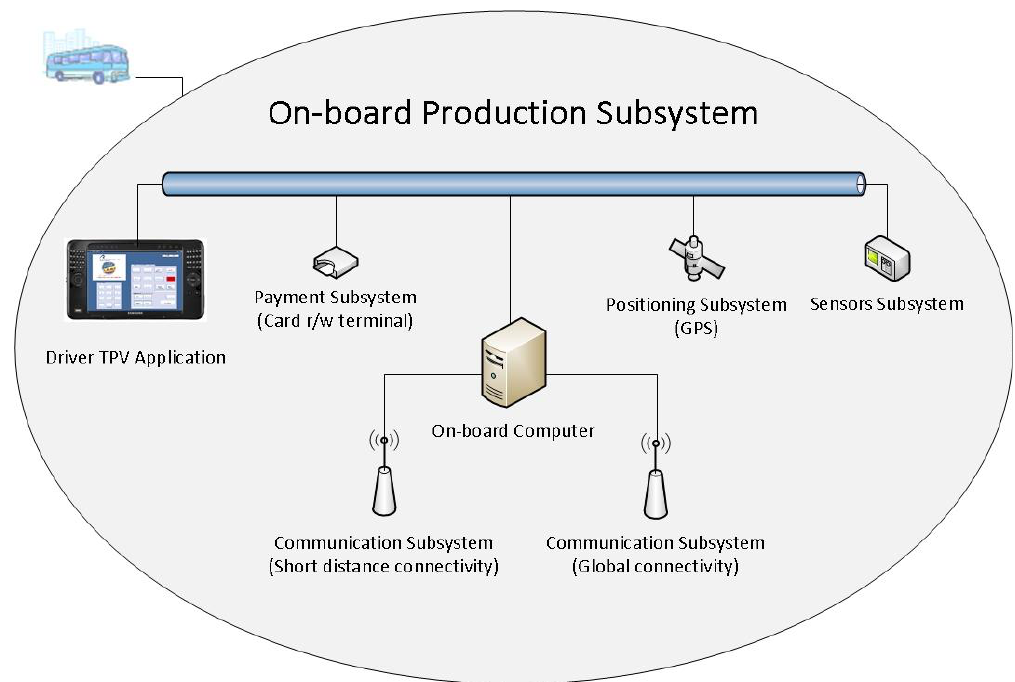
Figure 1. On-board production